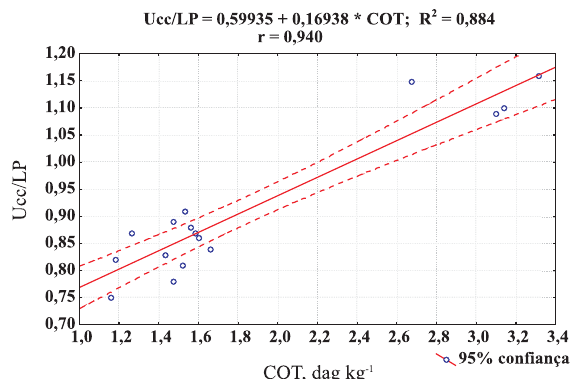
Figura 4. Relação entre a razão Ucc/LP e o carbono orgânico total (COT) do solo, na profundidade de 0–0,20